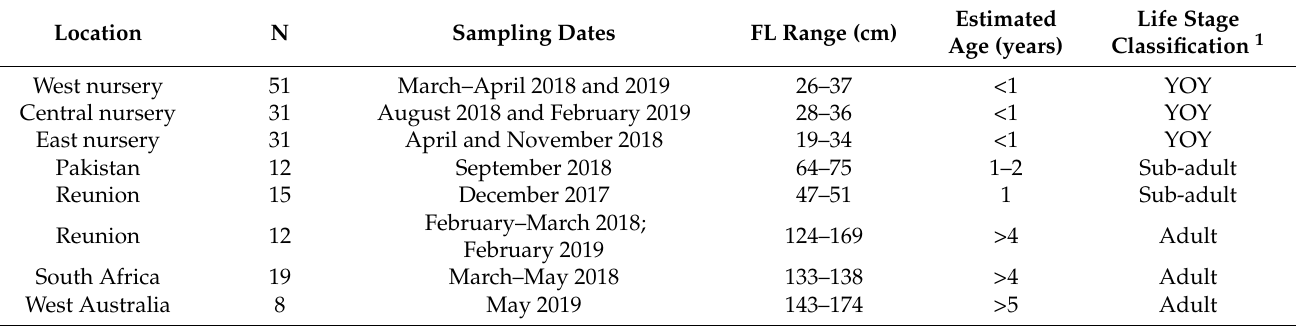
Table 1. Number, sampling period, size, and estimated ages of yellowfin tuna ( Thunnus albacares ) at each sampling area. Size is fork length (FL) in